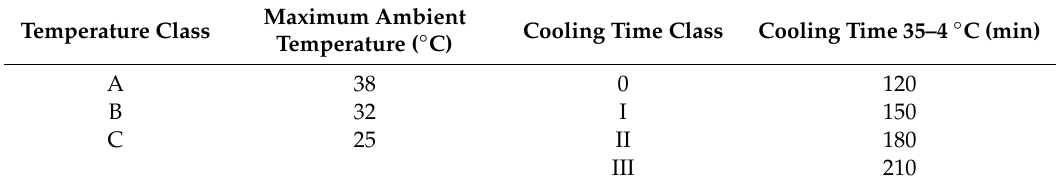
Table 1. Performance classes of milk cooling systems, according to the European Union (EU) regulation EN